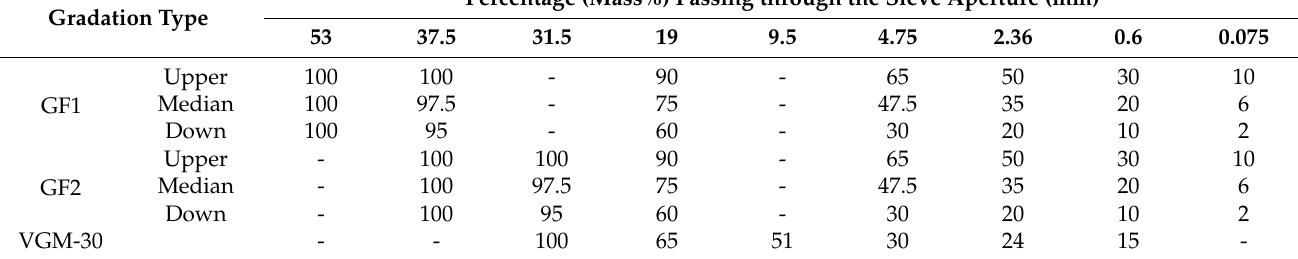
Table 3. Aggregate